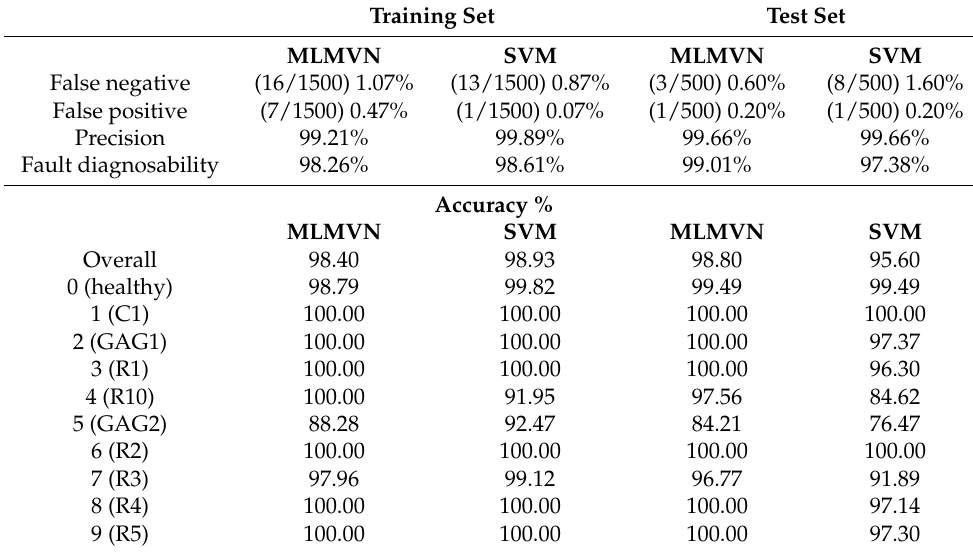
Table 3. Fault classification results in active low pass filter.